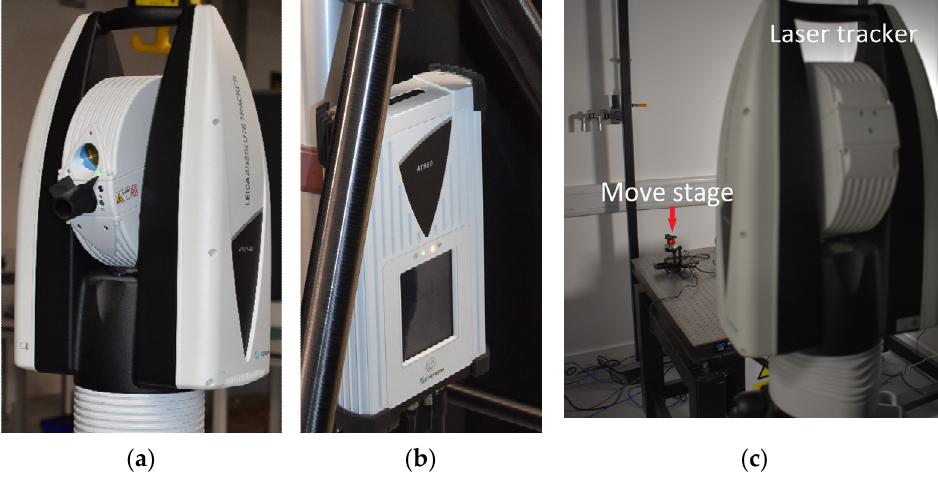
Figure 3. Laser tracker: ( a ) camera; ( b ) controller; ( c ) overall system. Table 1 . Measuring equipment characteristics and speci fi cations.